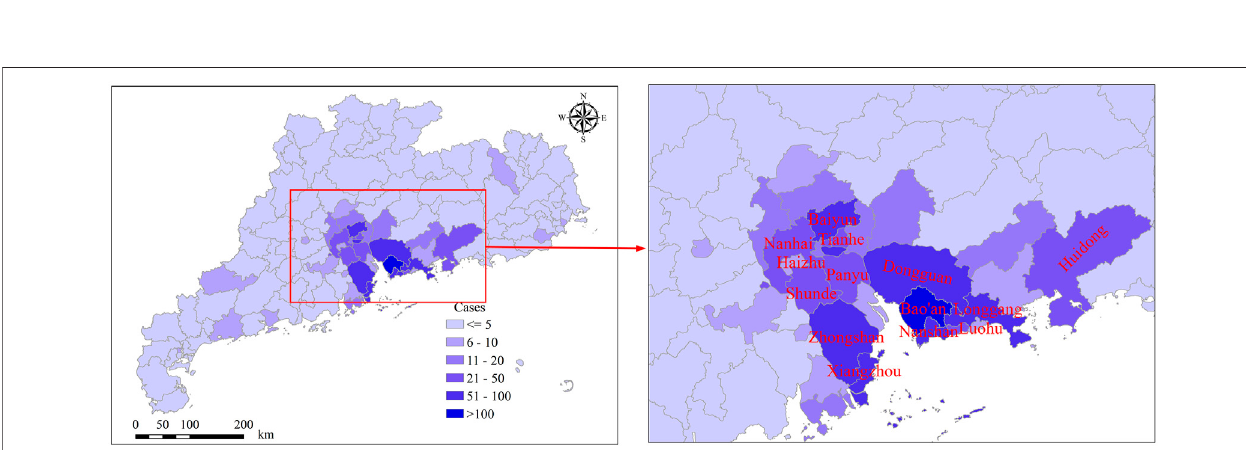
Frontiers in Environmental Science |